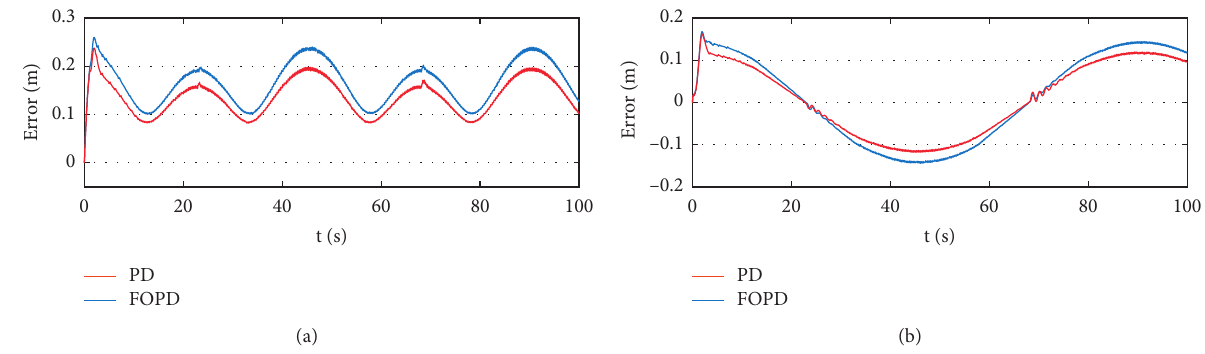
Figure 10: Errors comparison. (a) Absolute error. (b) X axis